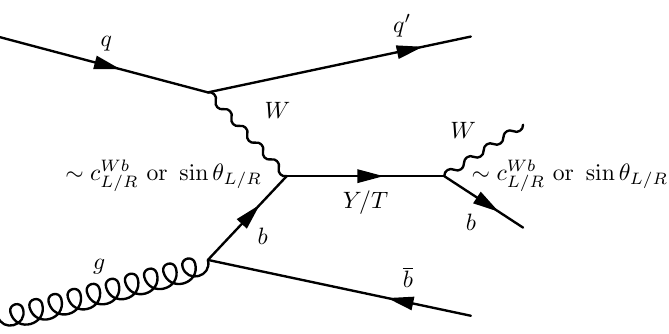
Figure 1. Leading-order Feynman diagram for single Y / T production in Wb fusion and subsequent decay into Wb . The production amplitude scales with sin (cid:18) L ; R [1] or c Wb the